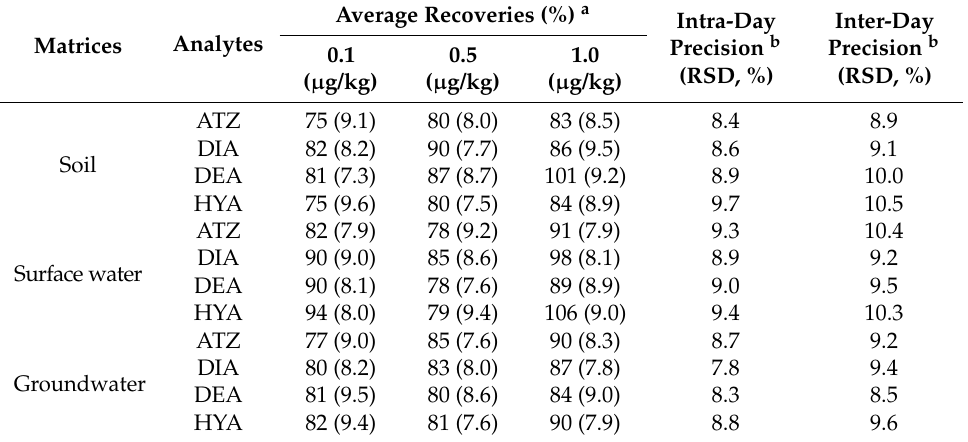
Table 2. Recoveries and precisions for the analytes spiked in soil and water samples.